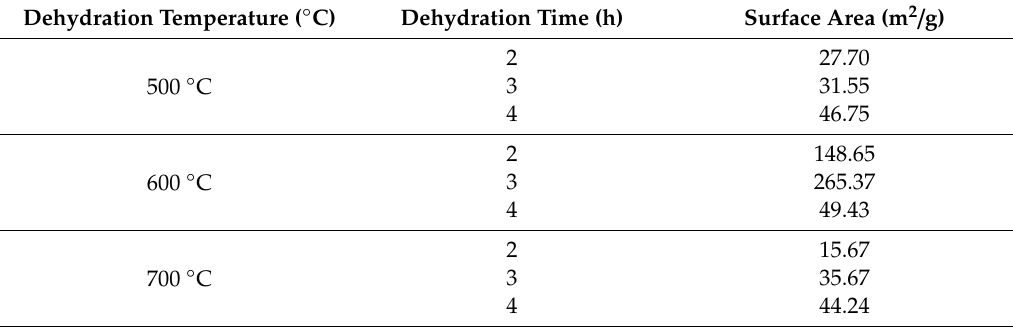
Table 3. BET surface area of the obtained Fe 3 O 4 / CaO